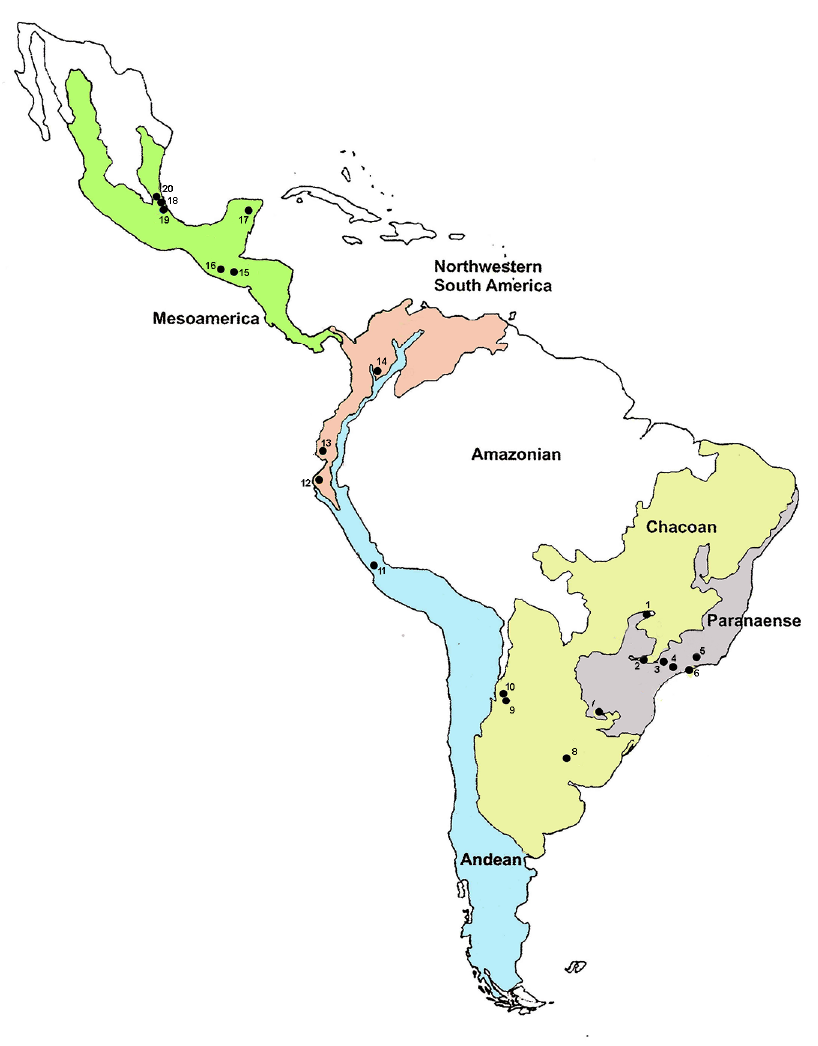
Figure 1. Collection sites of the Anastrepha fraterculus complex samples. Major biogeographical sub-areas in the Neotropical Region [28], showing the approximate locations of collection sites of the A. fraterculus samples: Brazil: 1. Uberlândia; 2. Botucatu; 3. Santa Isabel; 4. São Luís do Paraitinga; 5. Três Rios; 6. Ubatuba. Argentina: 7. Posadas; 8. Concordia; 9. Tucumán; 10. Horco Molle. Peru: 11. La Molina; 12. Piura. Ecuador: 13. Guayaquil. Colombia: 14. Ibagué. Guatemala: 15. Guatemala City. Mexico: 16. Tapachula; 17. Quintana Roo; 18. Teocelo; 19. Apazapan; 20. La Jicayana.